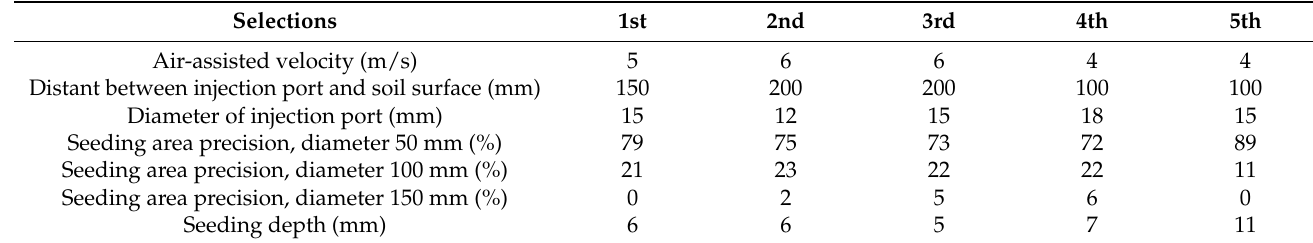
Table 4. Selection results with respect to optimal seeding accuracy.